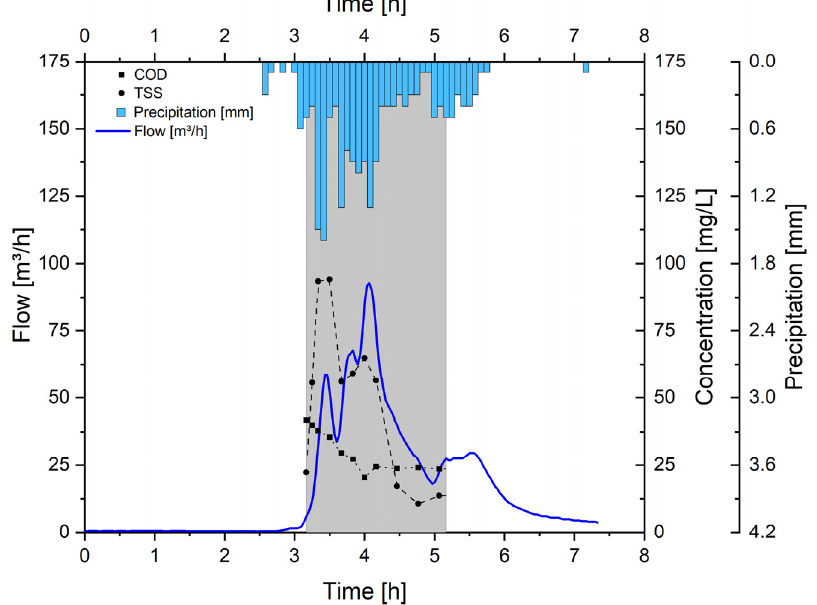
Figure 1. Variation in pollution dynamics during a rainfall event showing the runoff flow (1st y -axis), pollutant concentration (2nd y -axis, parameters COD ( ■ ) and TSS ( ● )) and precipitation data (3rd y -axis) over time.